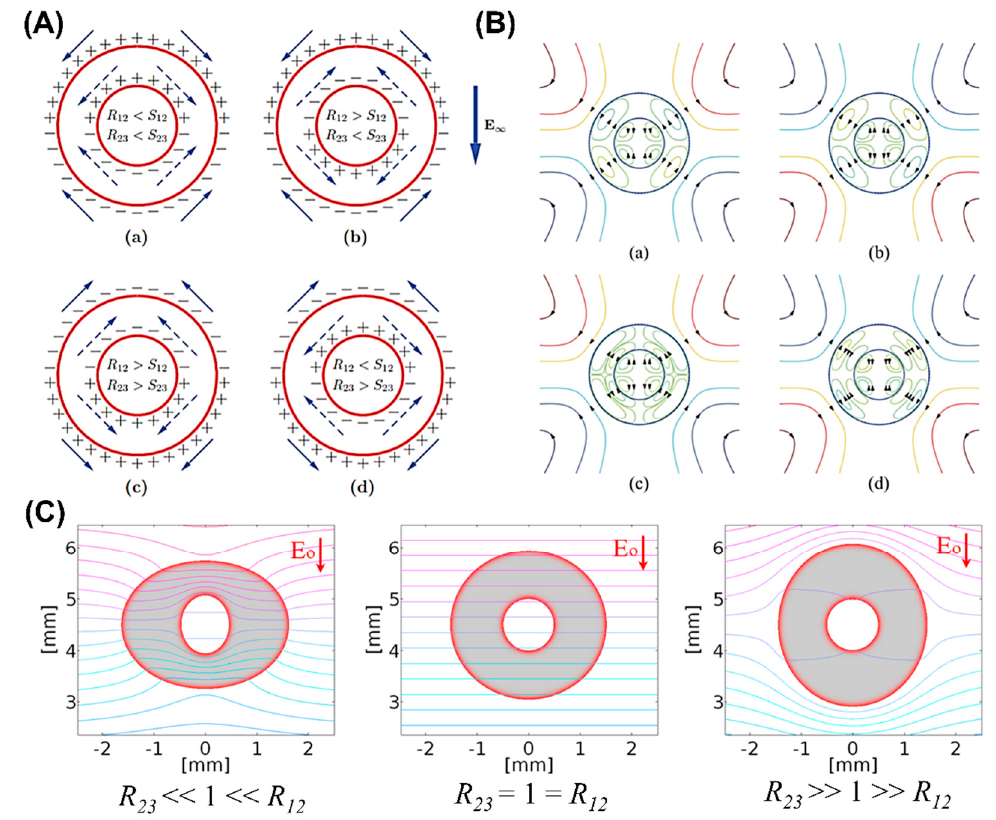
Figure 8. Dynamics of a double-emulsion droplet depending on relative magnitudes of permittivity ratio and conductivity ratio under a weak electric field. ( A ) Free electric charge distributions for four distinct cases. Solid and dashed arrows show the direction of tangential electric stresses at the interfaces. ( B ) Scenarios of different flow patterns [143] . ( C ) Contours of electric potential lines [14] .